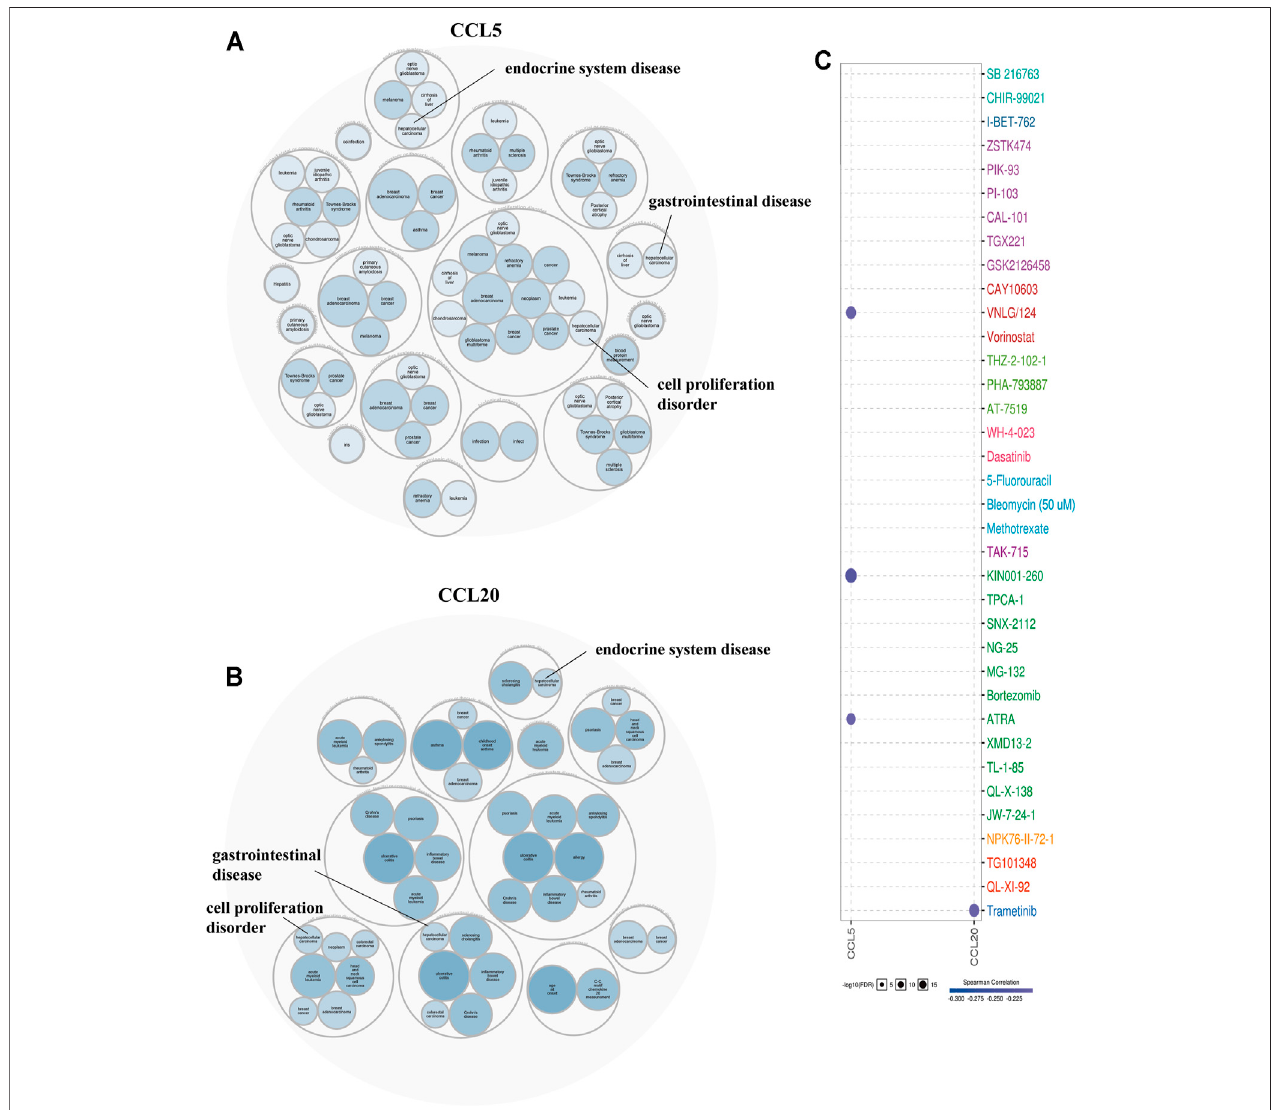
FIGURE 9 | Disease correlation (Open Targets) and drug resistance analysis (GSCALite) of aberrantly expressed chemokines CCL. (A) Diseases related to CCL5, (B) Diseases related to CCL20. (C) Drug resistance analysis of chemokines CCL5 and CCL20.